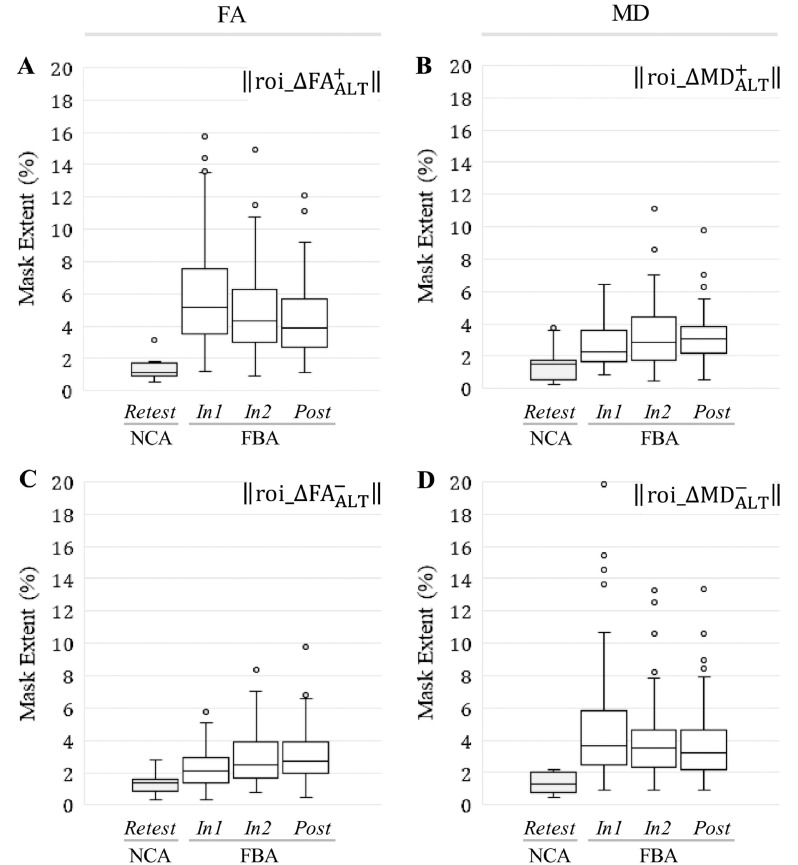
At all follow-up sessions, football athletes (FBA) exhibited significantly (p < 0.001) greater spatial extents of substantial increase/decrease in FA and MD, within ROIALT, than did noncollision athletes (NCA). Box-and-whisker plots are presented at each follow-up session for (A) ‖roi_ΔFAALT,j,i+‖; (B) ‖roi_ΔMDALT,j,i+‖; (C) ‖roi_ΔFAALT,j,i−‖; (D) ‖roi_ΔMDALT,j,i−‖.